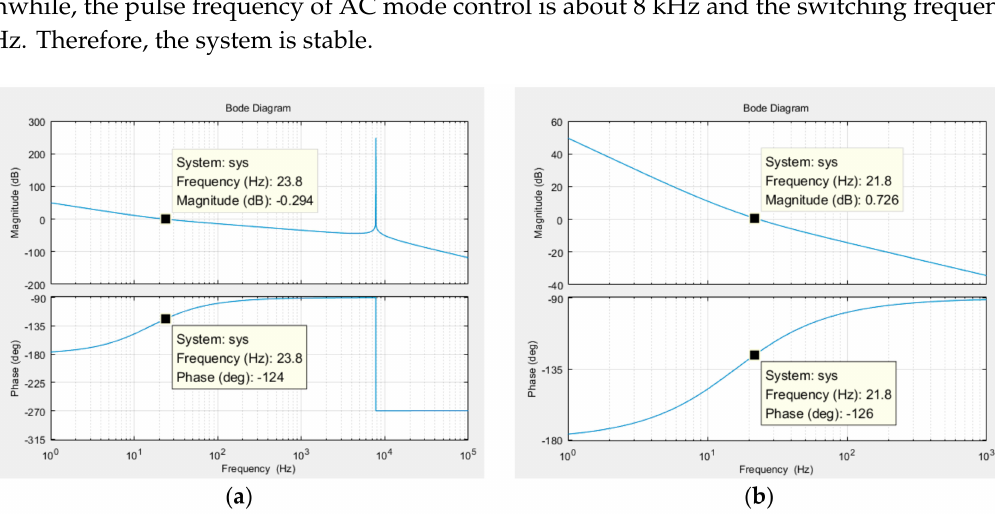
Figure 12. Bode plot of current control. ( a ) AC mode; ( b ) DC